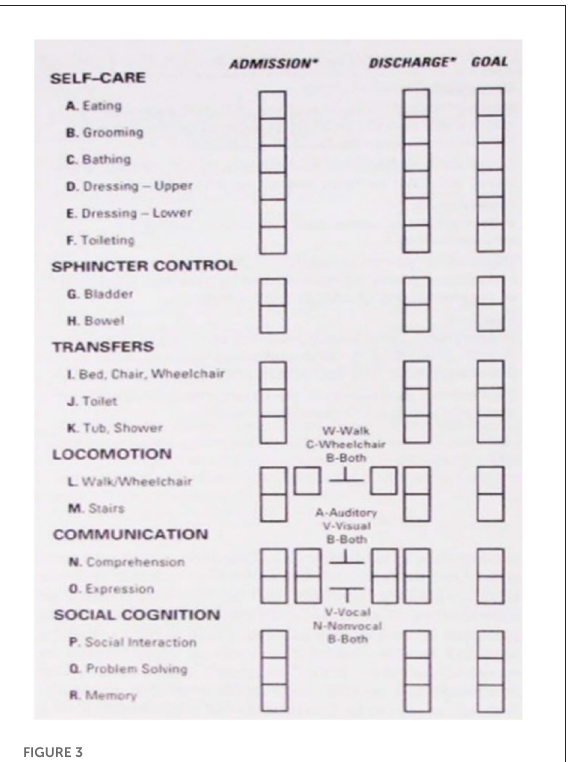
FIGURE3 Functional independence measure